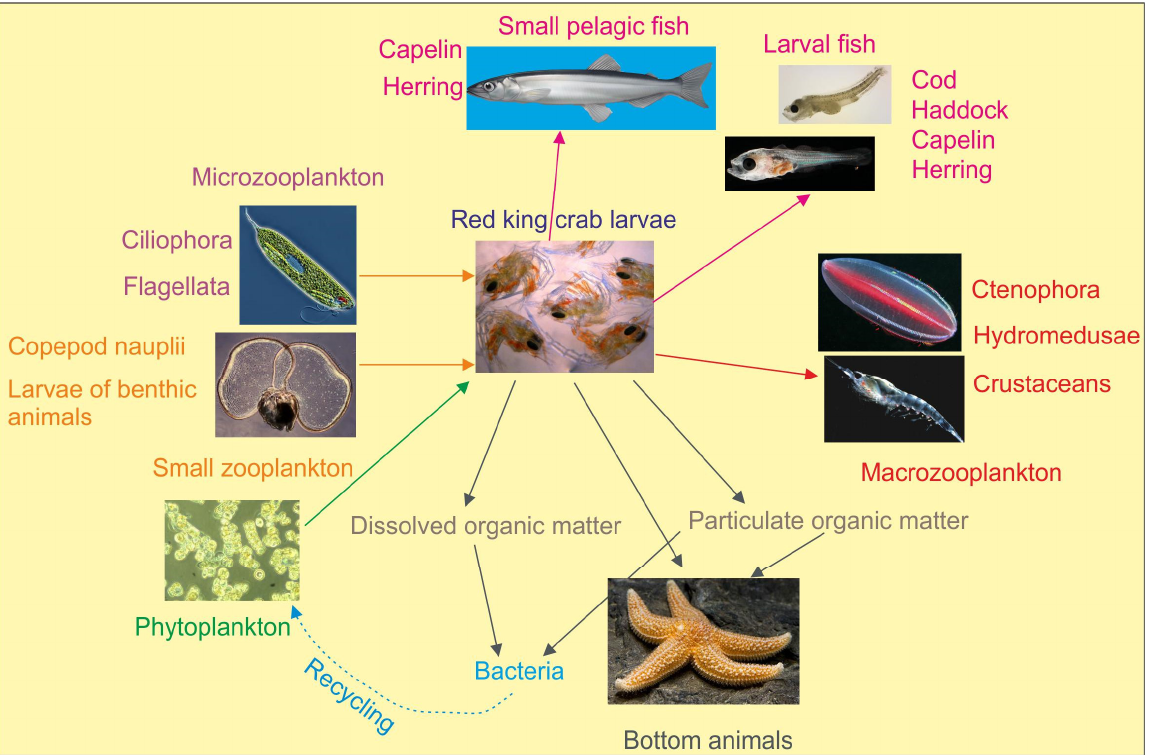
Figure 11. Trophic position of the red king crab larvae in the pelagic food web of the Barents